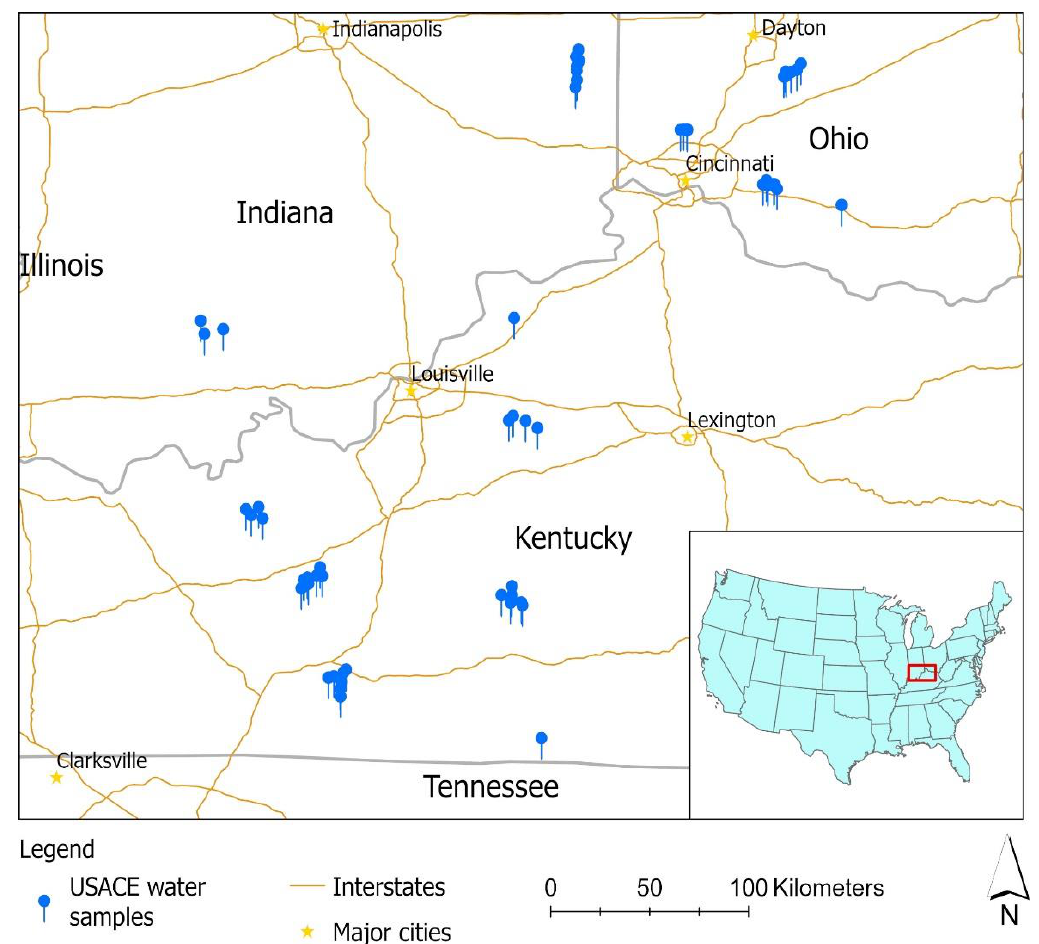
Figure 1. Study area: blue pins are the water samples collected by the USACE Louisville District Water Quality Team from May 2013 to November 2017.